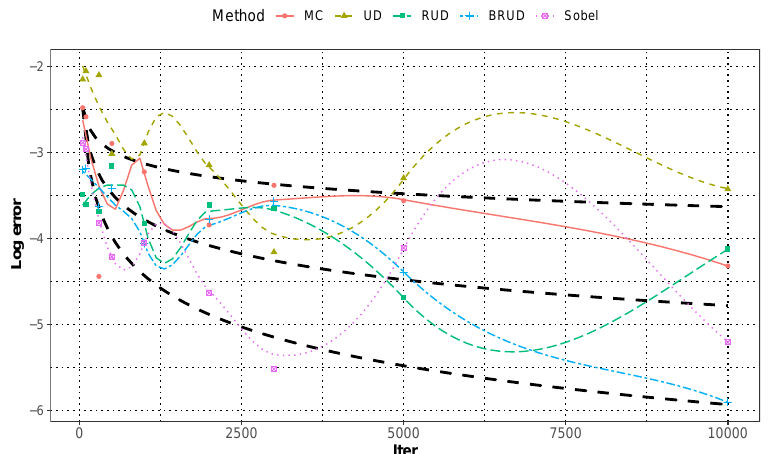
Figure 5. The approximation error of integration 2 for each runs in dimension s = 5 with Locally Weighted Regression.